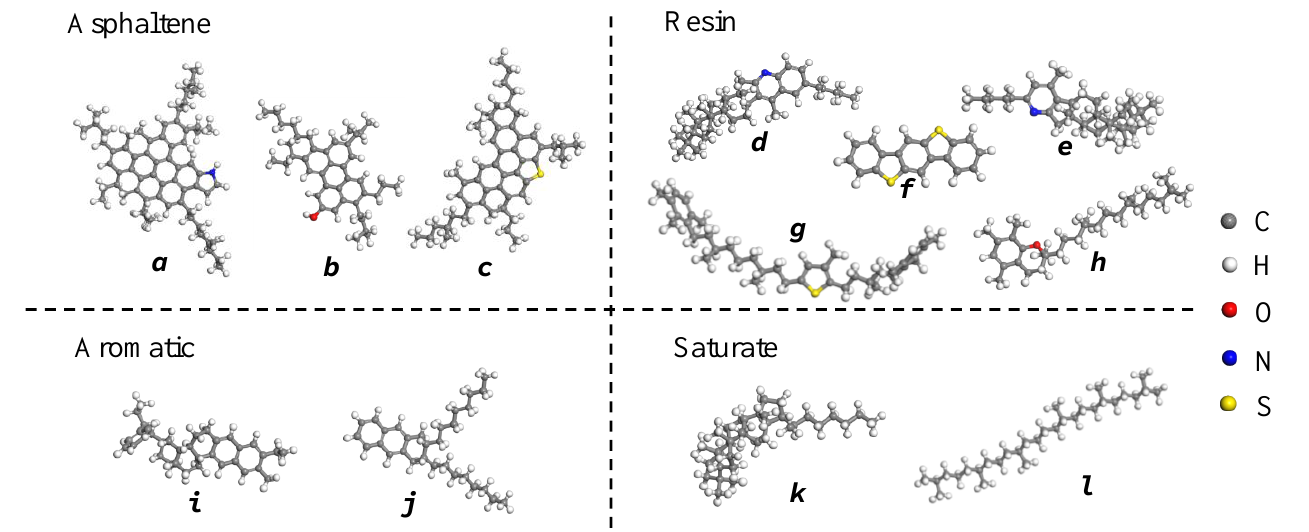
Figure 1. Representative molecules of the four components of neat asphalt binder: ( a – c ) asphal- tene; ( d – h ) resin; ( i – j ) aromatic; ( k – l ) saturate.